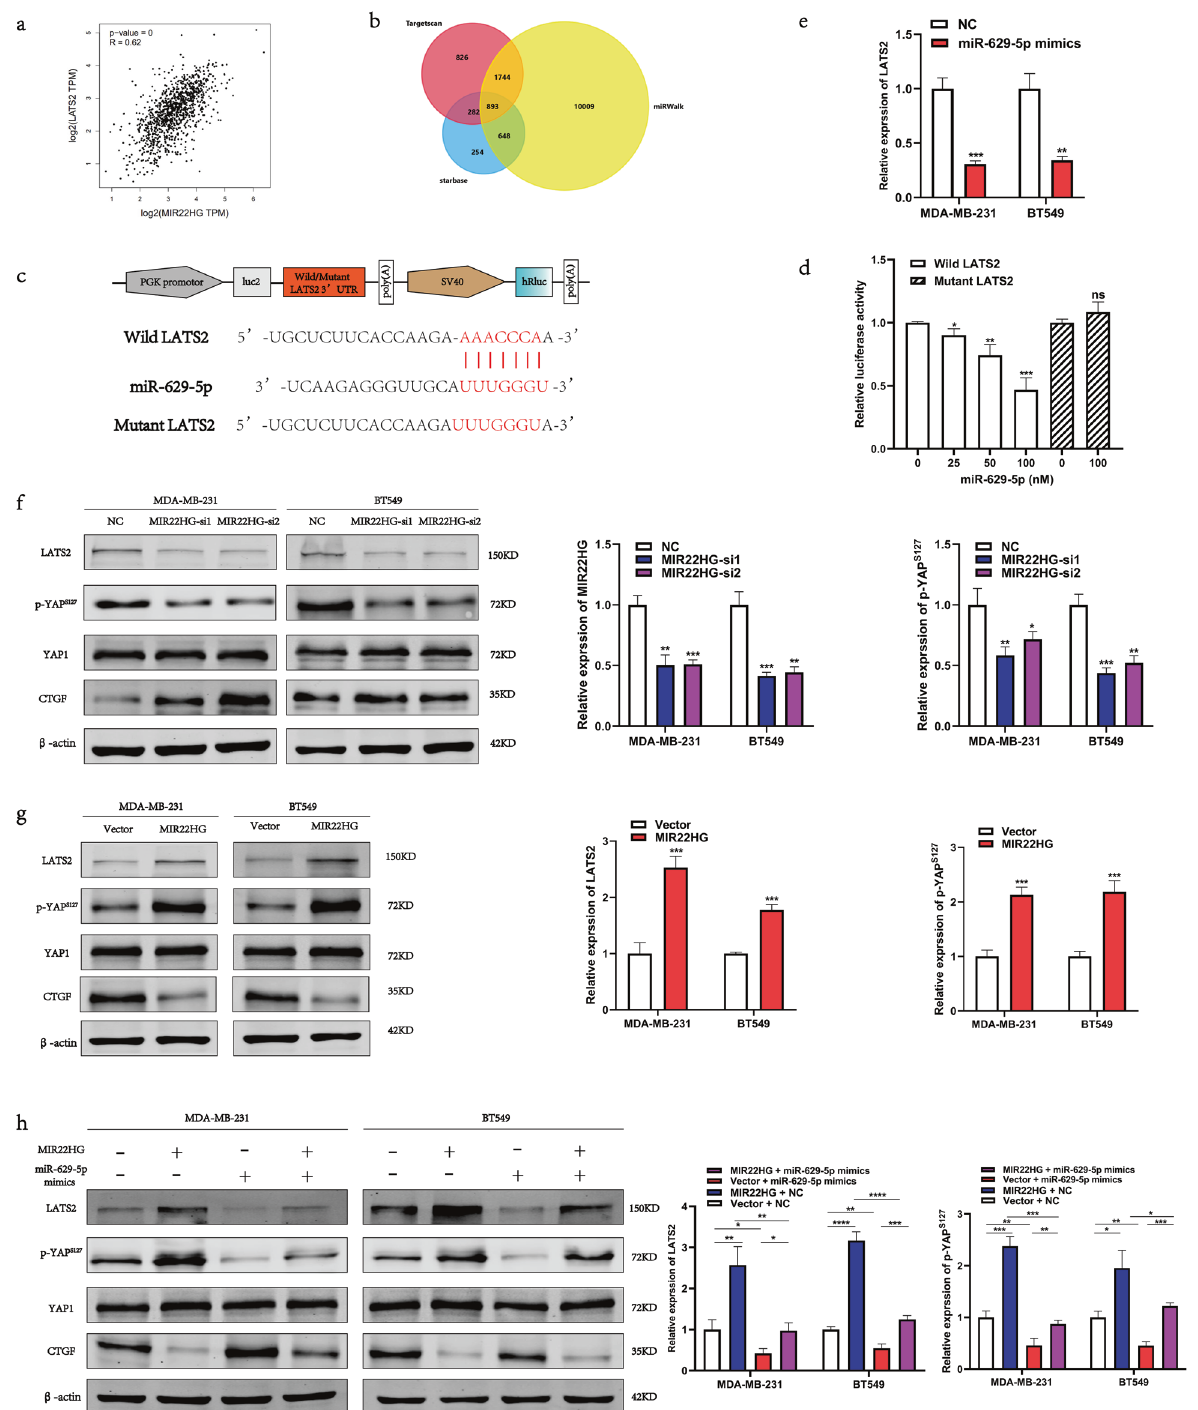
Fig. 6 MIR22HG regulates LATS2 expression via inhibition of miR-629-5p activity. a The expression correlation between MIR22HG and LATS2 based on the Gene Expression Pro fi ling Interactive Analysis 2 (GEPIA2) database. b Venn diagram showing the overlapping target genes of miR-629-5p predicted using the miRWalk, starBase, and TargetScan databases. c Schematic diagram of the interaction between miR-629-5p and wild-type/mutant LATS2 3 ′ -UTR. d Dual-luciferase assays of HEK293T cells co-transfected with wild-type/mutant LATS2 3 ′ -UTR and miR-629- 5p mimics (25, 50, and 100 nM) or NC. At 48 h after transfection, the 293 T cells were collected for the detection of fi re fl y luciferase activity, with Renilla luciferase activity as internal control. e Real-time PCR was performed to detect the changes in LATS2 expression in MDA-MB-231 and BT549 after transfection with miR-629-5p mimics for 48 h. f , g Expression of Hippo-YAP1 signals, namely LATS2, YAP1, phosphorylated YAP1 (S127), and CTGF, was assessed by Western blotting after MIR22HG knockdown or overexpression. h Western blot analysis revealed that miR-629-5p inhibited the expression of LATS2 , while MIR22HG was found to slightly counteract the miR-629-5p-induced reduction in LATS2 expression. * P < 0.05, ** P < 0.01, *** P < 0.001, **** P < 0.0001. All experiments were repeated